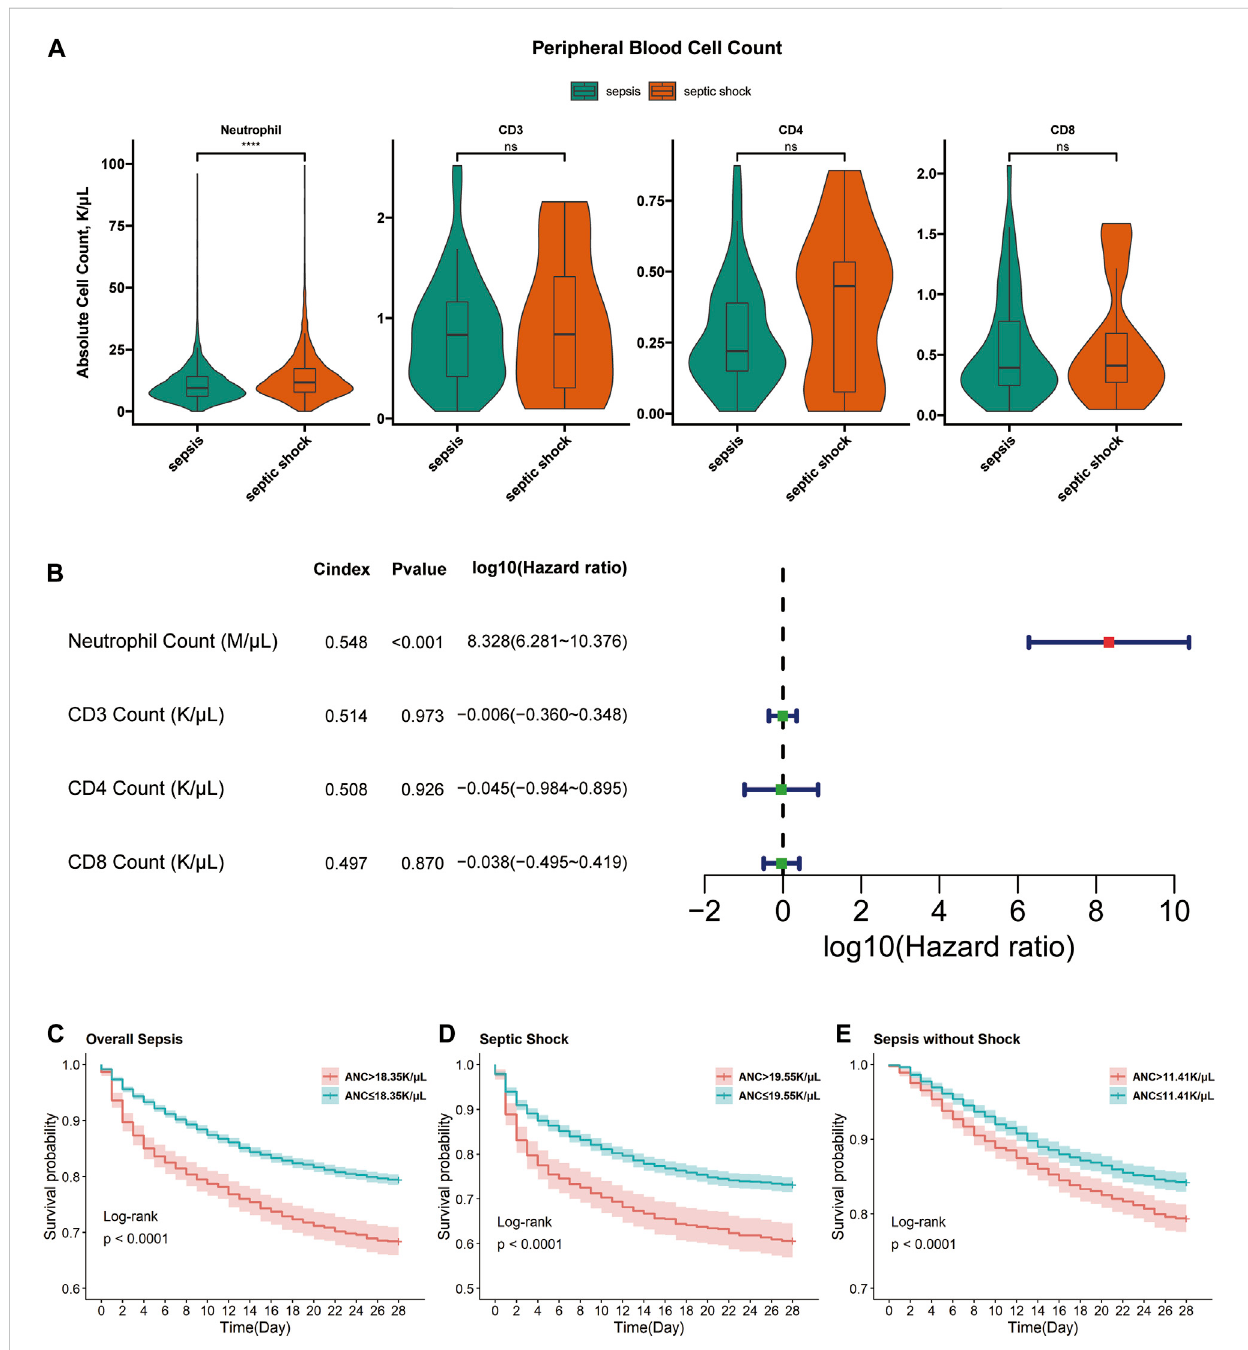
AssociationsofneutrophilsandTcellswithseptic shockandprognosisofoverall sepsis. (A) Comparisonsusingtwo-sample Wilcoxonrank sumtest of neutrophil counts between sepsis (n = 4,905) and septic shock (n = 3,345) samples, CD3 count between sepsis (n = 46) and septic shock (n = 23) samples, CD4 and CD8 counts between sepsis (n = 46) and septic shock (n = 22) samples. ns, non-sense; ****, p < 0.0001. (B) The forrest plots of 4 cell counts for overall sepsis samples (n = 8,250 for neutrophil count, n = 69 for CD3 count and n = 68 for CD4 and CD8 count). Red forest plots represent risky factors and green forest plots represent protective factors. (C) The KMcurves accessingtheprognosticassociationof absolute neutrophil count(ANC)inoverallsepsissamples.SampleswithANC > 18.35 K/uL(n=1,301)hadhigher28-daycumulativemortalitythansampleswithANC ≤ 18.35 K/ µL (n = 6,949) (31.59% vs. 20.56%, p < 0.0001). (D) The KM curves accessing the prognostic association of ANC in septic shock samples. Samples with ANC > 19.55 K/µL(n=640)hadhigher28-daycumulativemortalitythansampleswithANC ≤ 19.55 K/µL(n=2,705)(39.38%vs.26.84%, p < 0.0001). (E) The KM curves accessing the prognostic association of ANC in non-shock sepsis samples. Samples with ANC > 11.41 K/µL (n = 1827) had higher 28-day cumulative mortality than samples with ANC ≤ 11.41 K/µL (n = 3,078) (20.63% vs 15.76%, p <